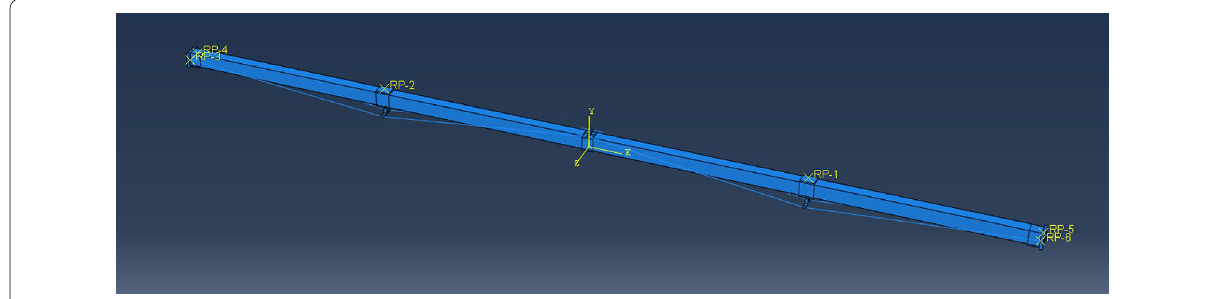
Fig. 16 Diagrammatic sketch of the FE model